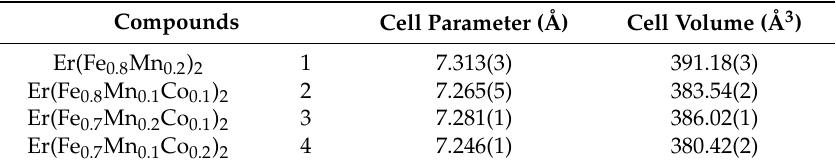
Table 1. Cell parameters at 300 K for Er(Fe 0.8 Mn 0.2 ) 2 , Er(Fe 0.8 Co 0.1 Mn 0.1 Co 0.1 ) 2 , Er(Fe 0.7 Mn 0.2 Co 0.1 ) 2 , and Er(Fe 0.7 Mn 0.1 Co 0.2 ) 2 refined from XRD.